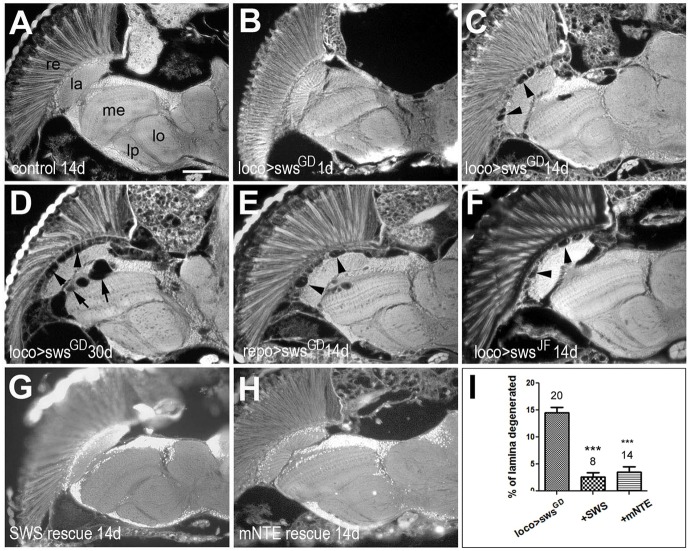
The glial knockdown of
SWS causes progressive vacuolization. (A) Paraffin head section from a 14-day-old (14 d) loco-GAL4;UAS-lacZ control fly does not reveal histological defects. Knocking down SWS using loco-GAL4 and UAS-swsGD3277 (swsGD) in all glia does not cause detectable phenotypes when 1 day old (B) but leads to increasing vacuolization, especially in the lamina cortex (arrowheads), when 14 days (C) or 30 days (D) old. In the 30-day-old knockdown flies, we also detected vacuoles near the first optic chiasm (arrows). A similar phenotype as in the 14-day-old loco-GAL4;UAS-swsGD3277 flies was detectable when driving UAS-swsGD3277 with repo-GAL4 (E) or when using loco-GAL4 and UAS-swsJF03428 (swsJF; F) of 14-day-old flies. (G,I) Co-expressing Drosophila UAS-SWS with swsGD using loco-GAL4 almost completely prevented the vacuolization in 14-day-old flies. (H,I) Similarly, murine NTE (mNTE) rescues the phenotype when co-expressed with swsGD in glia cells (via loco-GAL4; 14 days old). (I) Quantification of the lamina degeneration in 14-day-old knockdown and rescue flies. The number of analyzed laminae and the s.e.m. are indicated for each bar. ***P<0.001. re, retina; la, lamina; me, medulla; lo, lobula; lp, lobula plate. Scale bar: 25 µm.